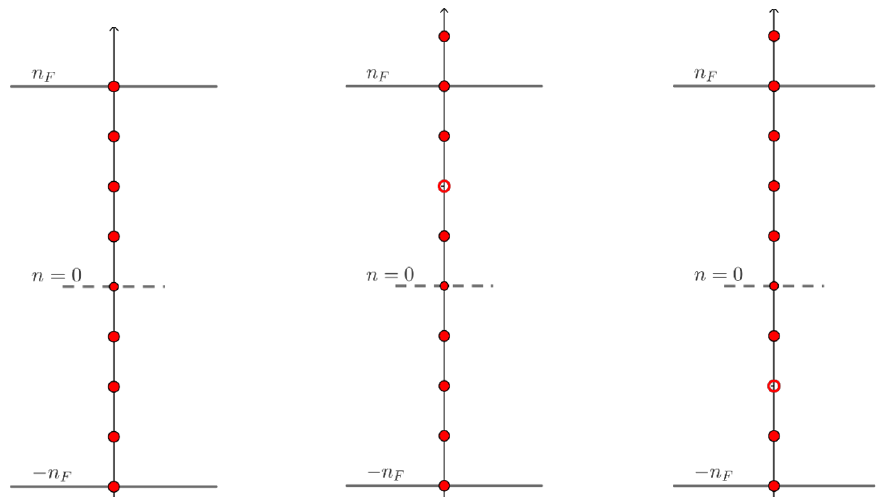
Figure 4 . Non-relativistic fermions: ground state (left) and two excited states (center, right). The two excited states are excitations over the positive Fermi surface. In the center, a fermion occupying a positive energy level jumps above the positive Fermi surface: this will correspond to a chiral state at large N . On the right, a fermion occupying a negative energy level jumps above the positive Fermi surface: this will be exponentially suppressed at large N